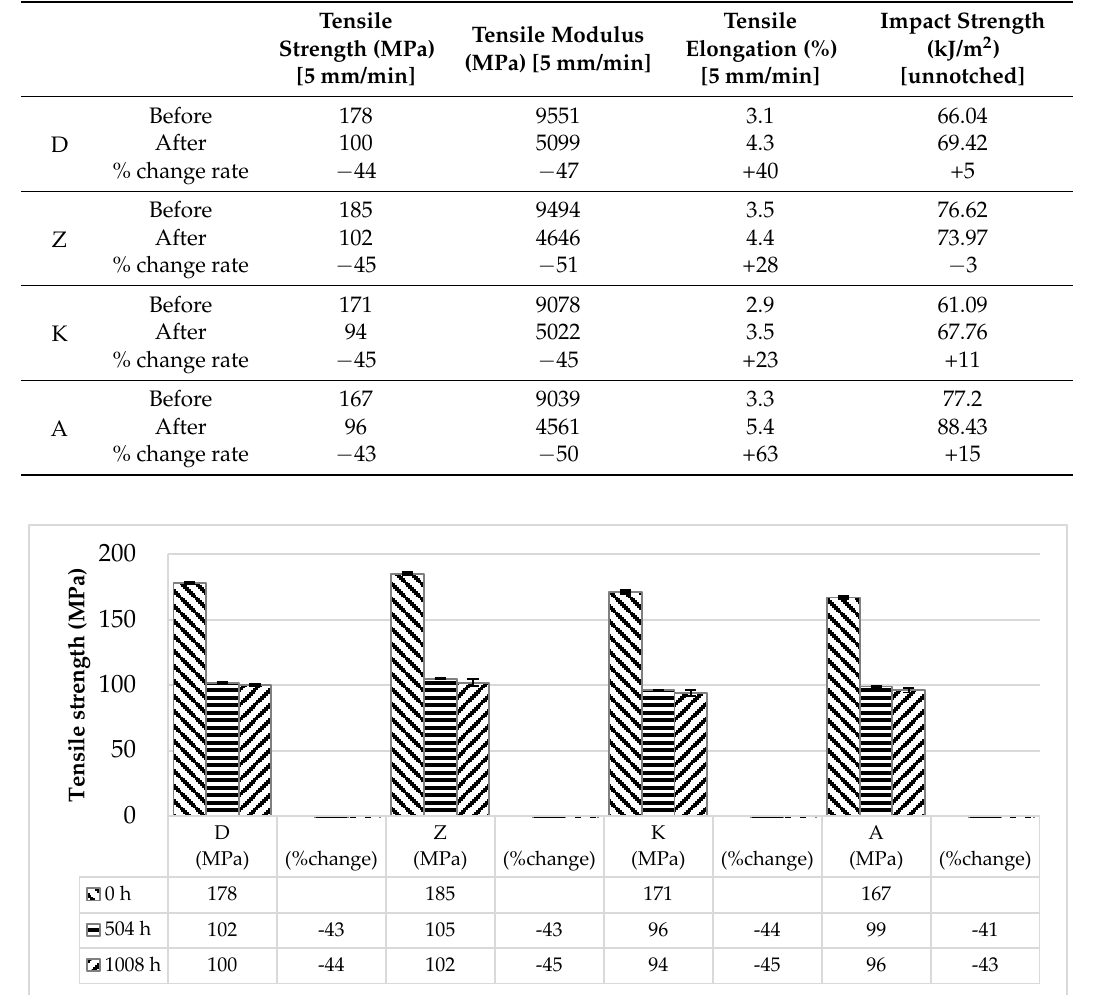
Figure 2. Hydrolysis of polyamide (adopted from Reference [37]).